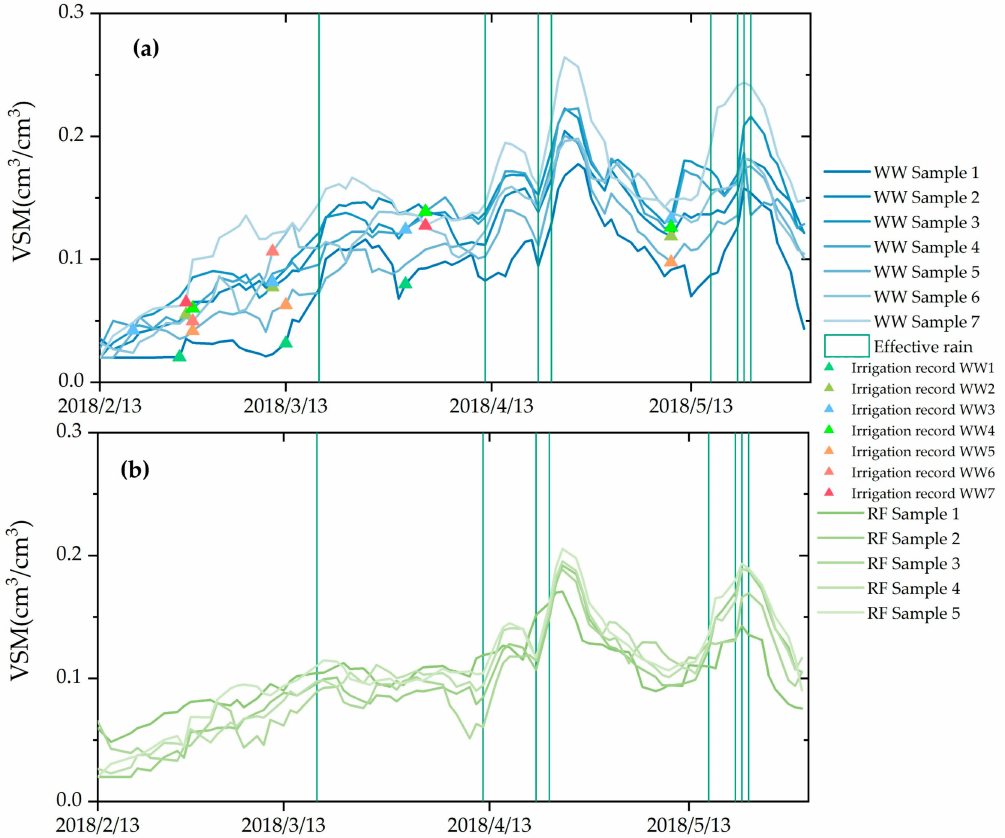
Figure 6. Training samples of irrigation signal detection. ( a ) Winter wheat training samples, and ( b ) rainfed crop training samples. The irrigation record is a summary of the irrigation records of the main irrigation region in the study area and used as a reference for the water supply time for winter